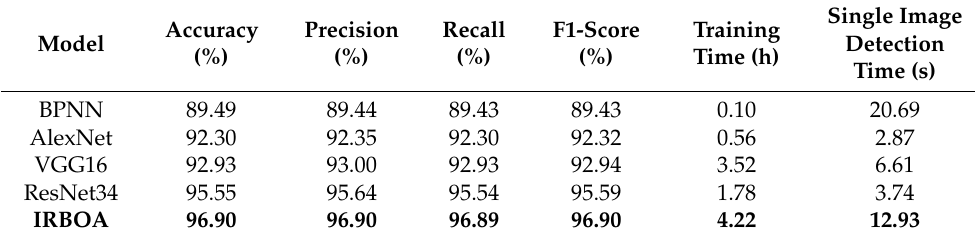
Table 4. Detection performance indicators for the five